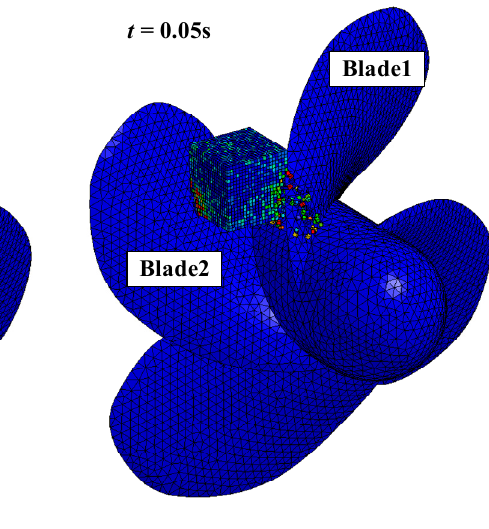
Figure 23. Numerical model of propeller-ice impacting at different collision locations.